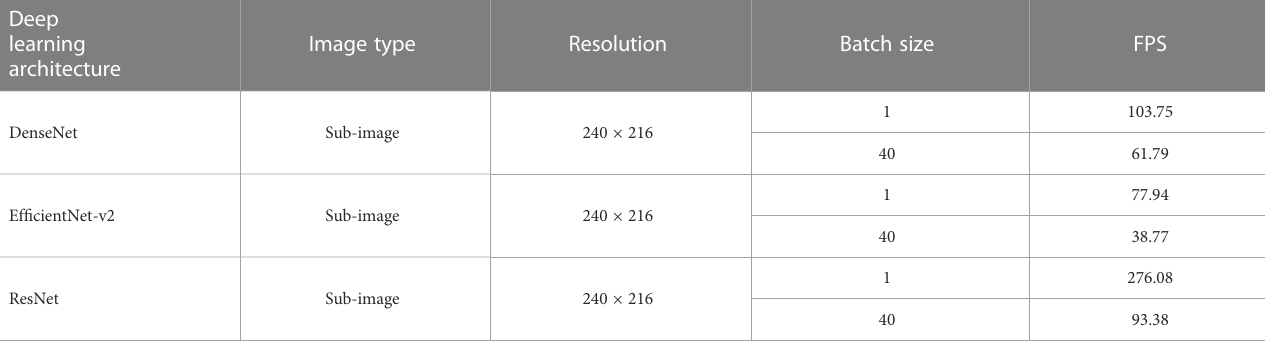
TABLE 5 The inference time of the convolutional neural networks evaluated in the study.